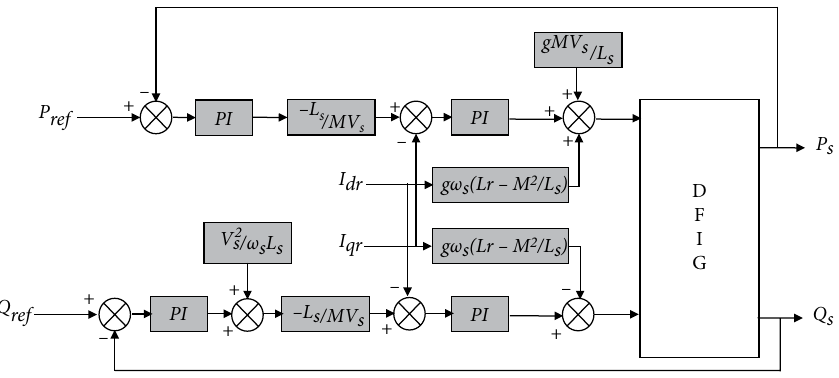
Figure 5: Indirect control of active and reactive power without power